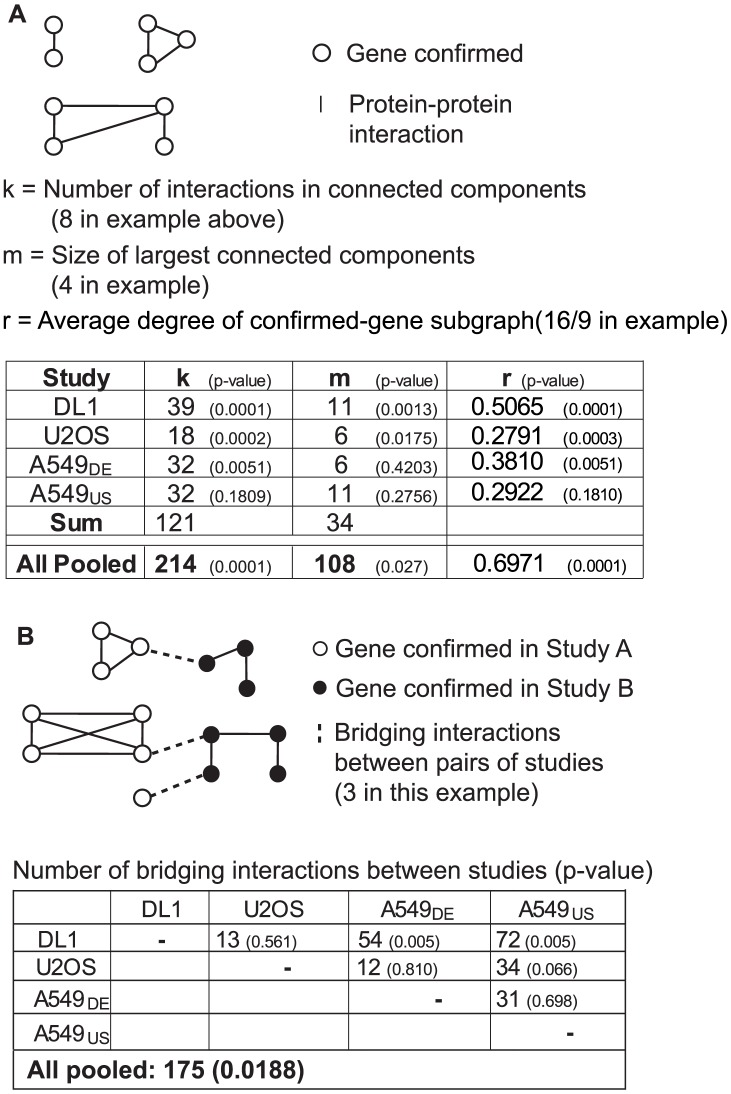
Genes implicated in different studies are related by physical interactions.
A) Physical interactions among implicated gene products define graphs that characterize the relatedness of the genes. Each circle represents a gene confirmed in at least one RNAi study and each edge represents a protein-protein interaction. The variable k represents the number of edges in the subgraph defined by a given set of confirmed genes, m represents the number of genes in the largest connected component, and r represents the average degree of the confirmed genes in this subgraph. The values of k, m and r for each RNAi study as well as the values for the interaction subgraph resulting from pooling all four studies are shown in the table. P-values correspond to the null hypothesis that the k, m, and r values can be accounted for by randomly selected sets of pseudo “confirmed” lists. P-values were calculated based on Monte Carlo tests with 9,999 randomized data sets having the same size and interaction properties as the RNAi studies being considered. B) Spanning interactions relate genes identified in different studies. Black and white circles represent genes from two different studies, solid edges indicate protein-protein interactions relating genes identified within the same study, and dashed lines indicate spanning interactions, which link genes confirmed in different studies. The numbers of spanning interactions between pairs of studies, and among all four studies pooled, are shown in the table. P-values correspond to the null hypothesis that the counts of spanning interactions can be accounted for by randomly selected sets of “confirmed” gene lists.